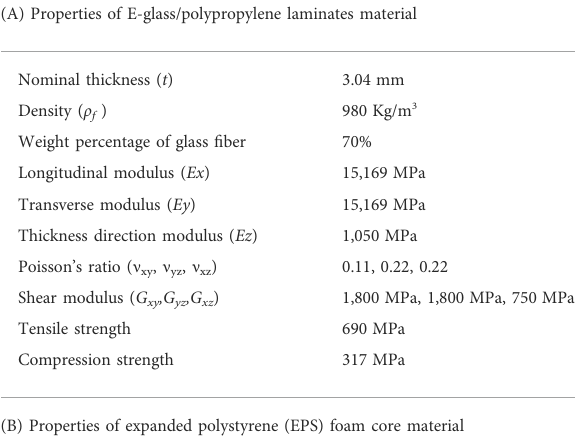
TABLE 1 Properties of analysis